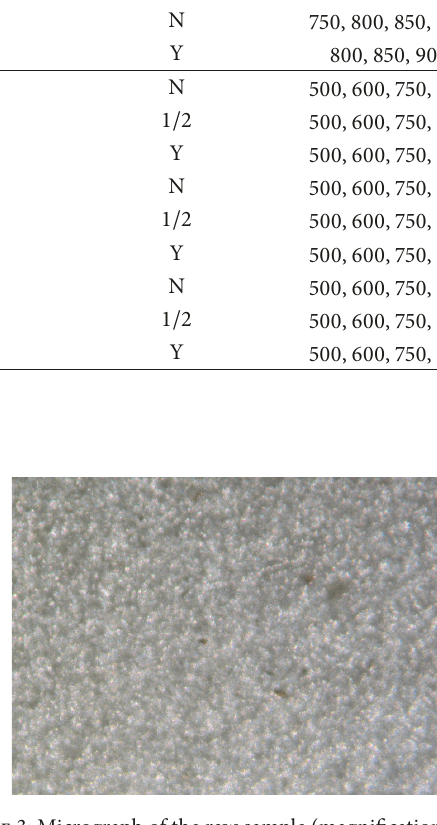
Figure 3: Micrograph of the raw sample (magnification: